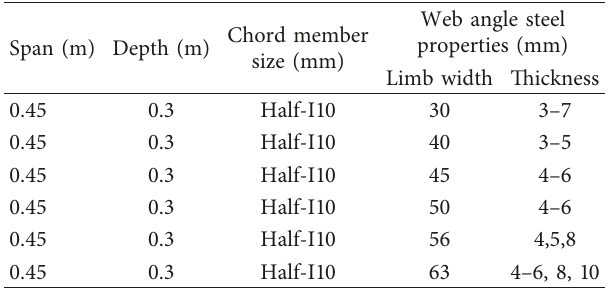
Table 3: Specimens